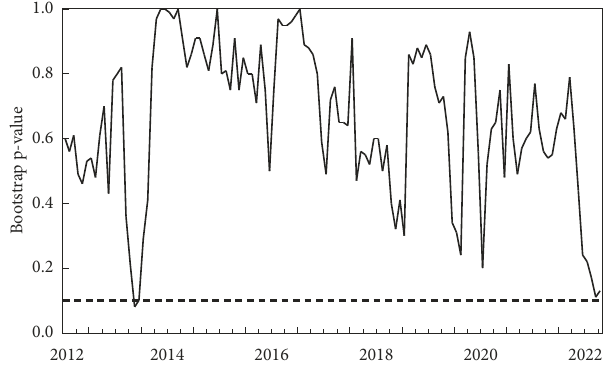
Figure 4. Examining the null hypothesis that BP does not Granger cause GSCP (source: authors’ calculations)